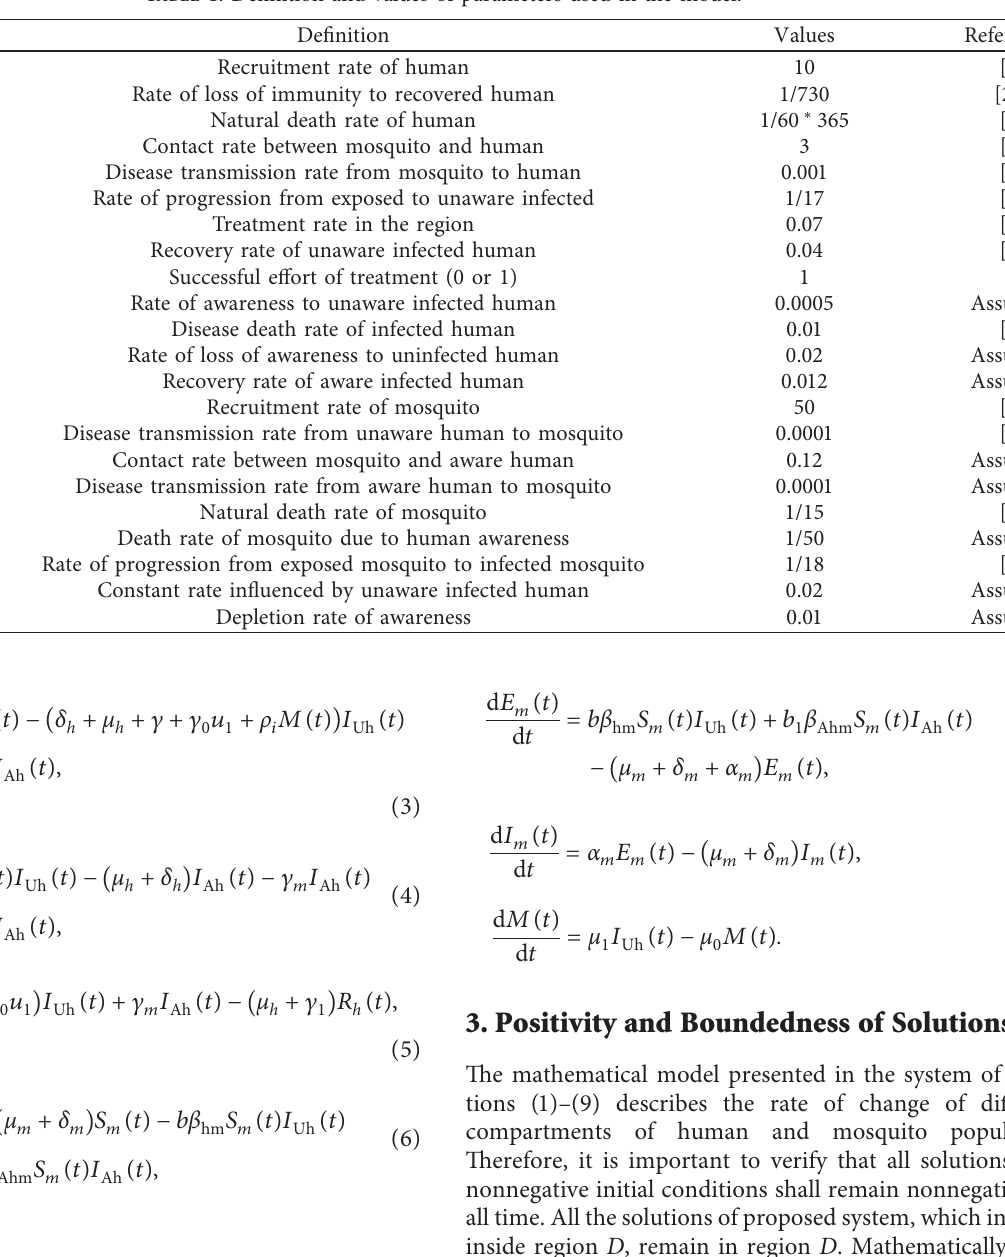
Table 1: Definition and values of parameters used in the